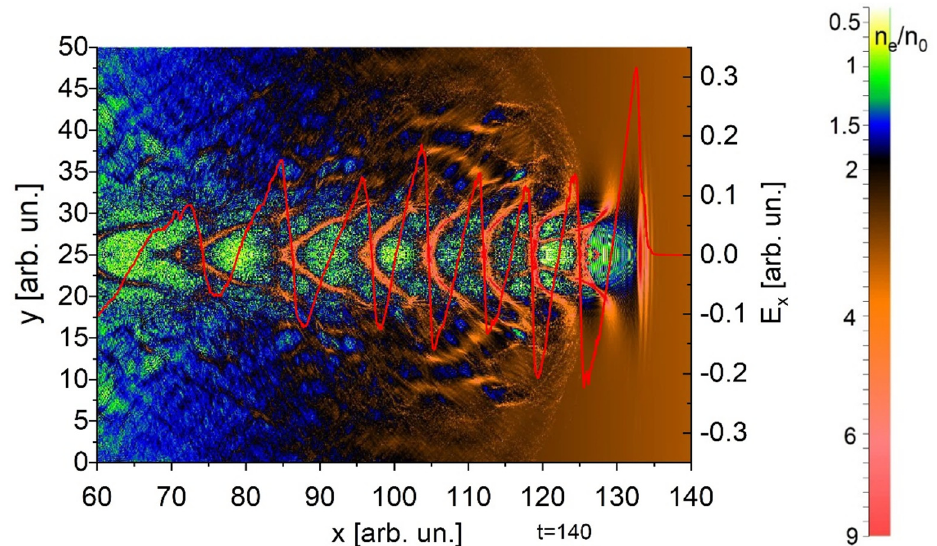
Figure 3. Excitation of a wakefield by a laser pulse in inhomogeneous plasma t = 60 T 0 . The self-injected bunch is close to the area of maximum accelerating gradient. Plasma electron density and longitudinal accelerating field distributions. x, y are normalized to λ , E x is normalized to E 0 = m e c ω ℓ /2 π e .